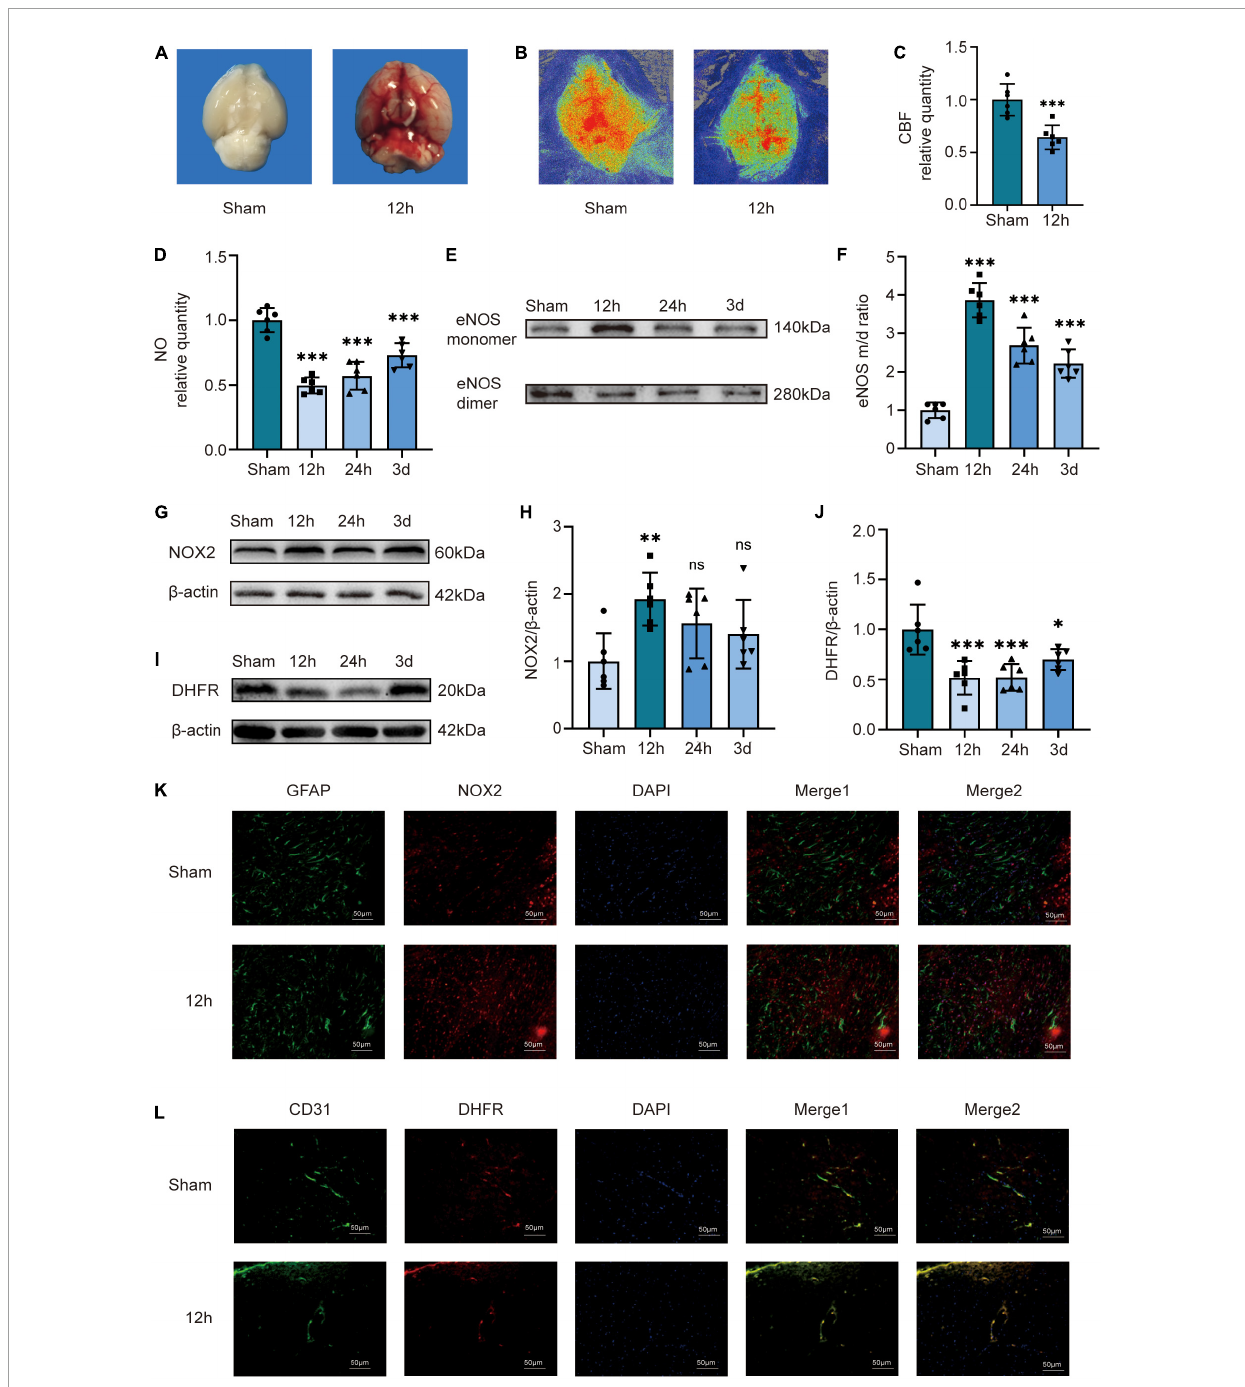
FIGURE1 Cerebral blood flow, NO content, NOX2, DHFR, and the ratio of eNOS monomer/dimer in the temporal lobes of mice at different time courses after SAH in mice. (A) Compared to the Sham group, there was a larger amount of blood at the bottom of the brains of the 12 h group mice. (B) Representative LSCI images in these two groups. (C) Quantitative analysis of CBF in these two groups. Data are shown as mean ± SD ( n = 6 mice each group, ∗∗∗ p < 0.001). (D) NO content in extracted endothelial cells of the Sham group and different time course groups after SAH. Data are shown as mean ± SD ( n = 6 mice each group, ∗∗∗ p < 0.001). (E,F) Representative Western blot images and quantitative analysis of eNOS monomer and eNOS dimer expression in the Sham group and different time course groups after SAH by ImageJ. Data are shown as mean ± SD ( n = 6 mice each group, ∗∗∗ p < 0.001). (G,H) Representative Western blot images and quantitative analysis of NOX2 expression in the temporal lobes of the Sham group and different time-course groups after SAH by ImageJ. Data are shown as mean ± standard deviation ( n = 6 mice each group, ∗∗ p < 0.01, ns: no statistically significant difference). (I,J) Representative Western blot images and quantitative analysis for endothelial DHFR expression in the temporal lobe of mice in the Sham group and different time course groups after SAH by ImageJ. Data are shown as mean ± SD ( n = 6 mice each group, ∗ p < 0.05, ∗∗∗ p < 0.001, ns: no statistically significant difference). (K) Immunofluorescence images showed GFAP and NOX2 colocalization. All scale bars, 50 µ m. (L) Immunofluorescence images showed CD31 and DHFR colocalization. All scale bars, 50 µ m. CBF, cerebral blood flow; eNOS, endothelial nitric oxide synthase; NOX2, nicotinamide adenine dinucleotide phosphate oxidase 2; GFAP, glial fibrillary acidic protein; DHFR, dihydrofolate